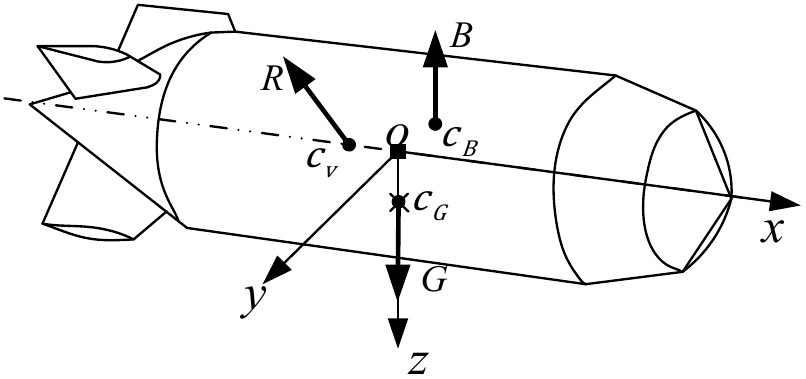
Figure 1. Aerodynamic Layout Diagram of Stratospheric Airship. The relevant parameters of the stratospheric airship are shown in the Table 1. Table 1. Relevant Parameters of Stratospheric Airship.